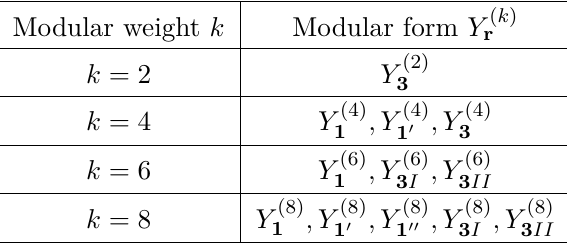
modular symmetry. Here Y (6) and Y (6) stand for two weight 6 modular 4 3 I 3 II . Similar conventions are adopted for Y (8) and Y (8) . 4 3 I 3 II